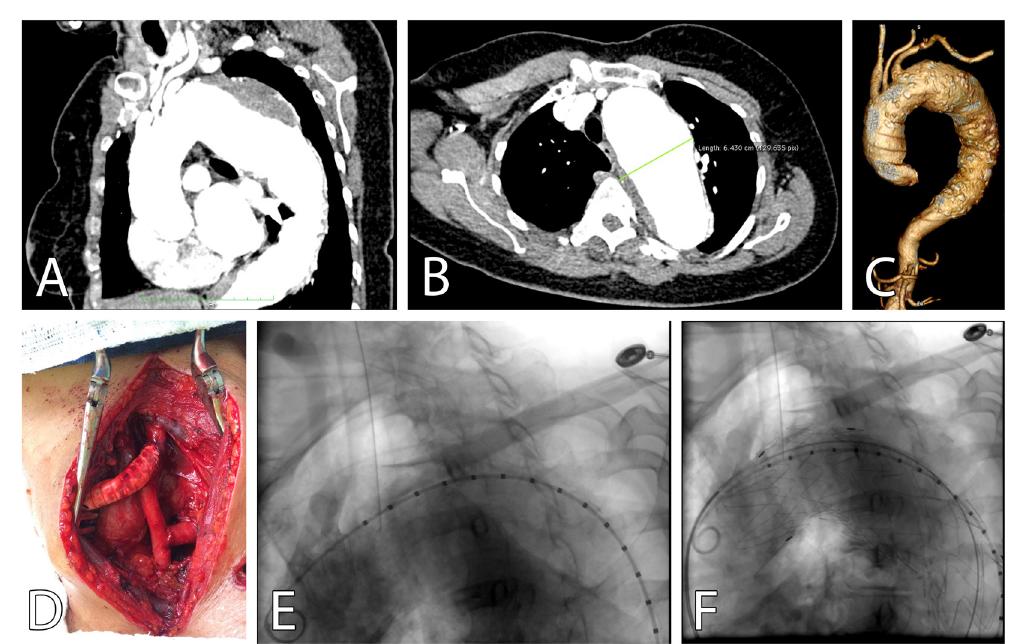
Fig 4 - Carotid-carotid graft associated with transposition of the left subclavian artery and stent-graft implantation in Zone 1. A: Angiotomography in sagittal section with thoracic aneurysm without proper anchoring zone in Zone 2 due to extreme proximity between the left carotid and the left subclavian arteries. B: Angiotomography in axial section showing massive thoracic aneurysm. C: Angiotomography with volume reconstruction. D: Supra-aortic trunk revascularizatoins with carotid-carotid graft associated with transposition of the left subclavian artery. E: Aortography before stent implantation with patency of anatomical extra grafts. F: Aortography after stent implantation demonstrating the aortic stent in Zone 1, no leaks and patency of supra-aortic